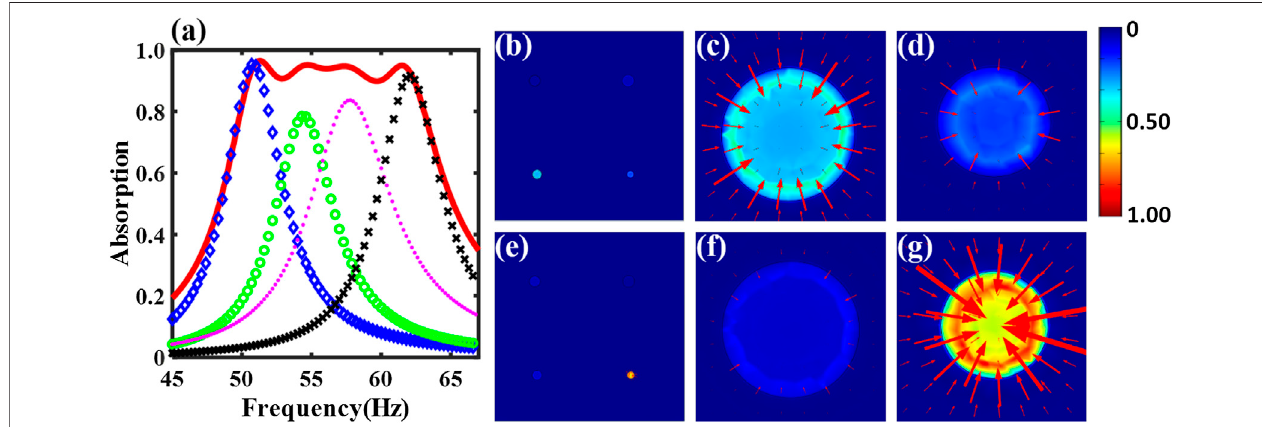
FIGURE5|(A) Thetheoreticalabsorptioncoef fi cientoftheoptimizedsupercell(redsolidline)andindividualunitcells(bluediamonds,greencircles,magentapoints and black crosses are for unit cell one, two, three, and four respectively). The curve for “ unit cell N ” is an absorption spectrum for a metasurface in which only unit cell N caninteractwiththeincidentsoundandalltheotherunitcellsareblockedatthefrontpanel. N (cid:1) 1,2,3,4.Soundintensitymapsoftheoptimizedsupercellat (B) 54.4 Hz and (E) 57.8 Hz, respectively. The bottom-left unit cell and the bottom-right unit cell of (B) are enlarged, as shown in (C) and (D) , respectively. The bottom-left unit cell and the bottom-right unit cell of (E) are enlarged, as shown in (F) and (G) , respectively. The incident pressure is normalized to 1 Pa. Color bar (w / m 2 ): component of thesoundintensityvectorthatareperpendiculartothesupercellsurface,i.e., I z .Arrow:componentsofthesoundintensityvectorthatareparalleltothesupercellsurface, i.e., I x and I y . The size of the arrows is proportional to the magnitude of the intensity.